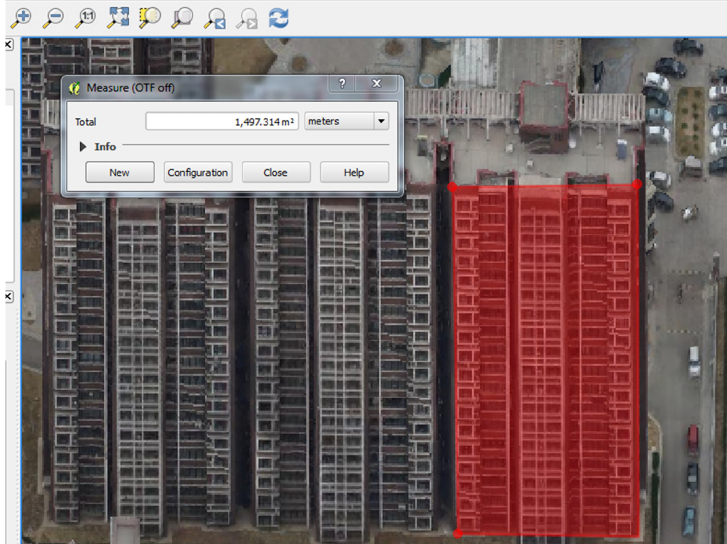
Figure 12. Measuring building façade area on a 2.5D map in a 2D GIS. Table 4. Comparison of the building heights measured on a 2.5D map and in a 3D GIS.